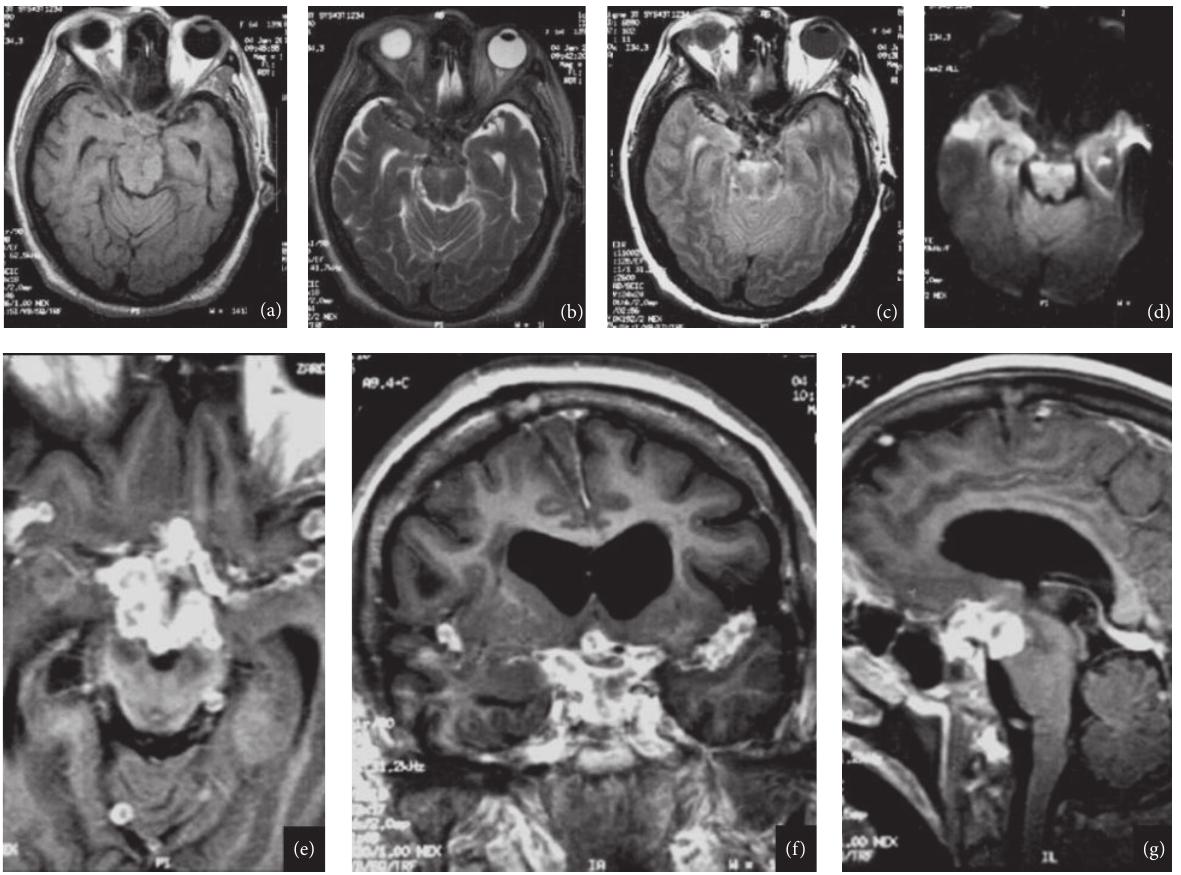
Figure 4: (a) Axial T1-weighted images, (b) axial T2-weighted images, and (c) axial T2- and T2-FLAIR-weighted images after contrast media administration. (e) Axial plane, (f) coronal, (g) sagittal MRI images of 57-year-old woman, six years before she had tuberculous meningitis, obstructive hydrocephalus secondary to multiple coalescent nodular well-defined images; the biggest was localized in the sella, the lesion in contact with the chiasm, and extends to cavernous sinuses. Multiple lesions were localized in basal cisterns and both lateral fissures and the retrosellar extension of the lesions cause brain stem